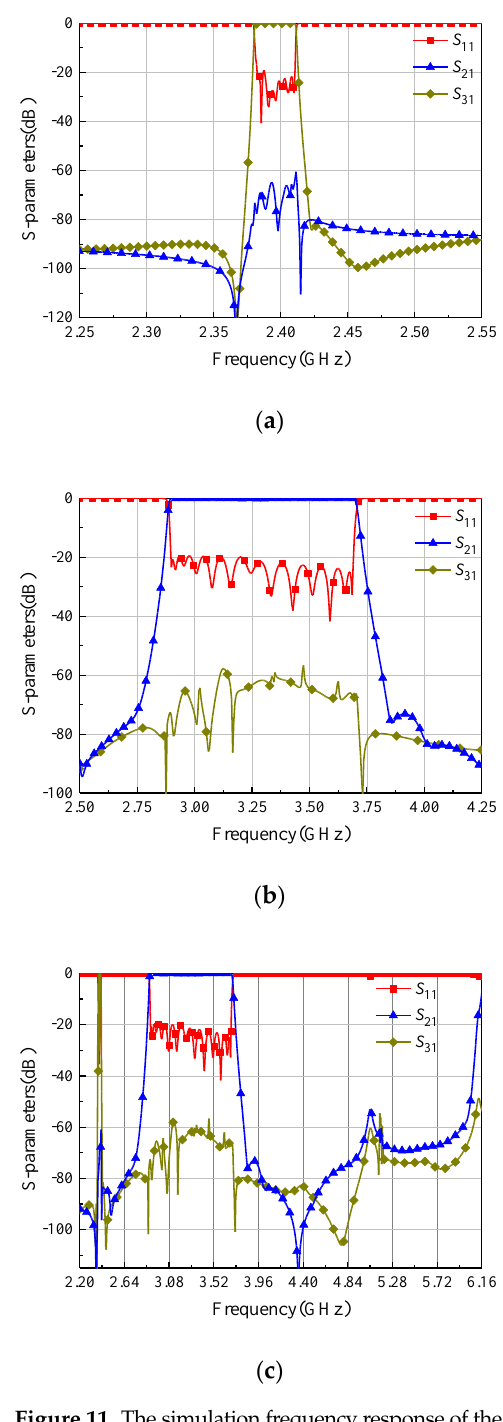
Figure 11. The simulation frequency response of the diplexer. ( a ) Channel I; ( b ) Channel II; ( c ) broad- band.